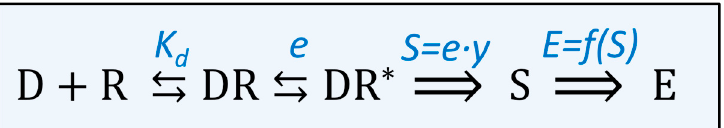
Figure 3. Scheme of the processes in the pharmacodynamic phase of a drug. The drug (D) binds to its receptor (R) and forms a drug–receptor complex (DR). The affinity of the drug for the receptor is described by the dissociation constant ( K d ). After binding to the receptor, the receptor can be activated (R*). The potency of a drug to activate the receptor is described by the efficacy ( e ) of the drug. The activated drug–receptor complex generates a stimulus (S) that is proportional to the efficacy of the drug multiplied by the number of receptors occupied ( y ). The stimulus generates an effect (E), which is described by a stimulus effect relationship ( E = f(S) ) that depends on the organ and the type of